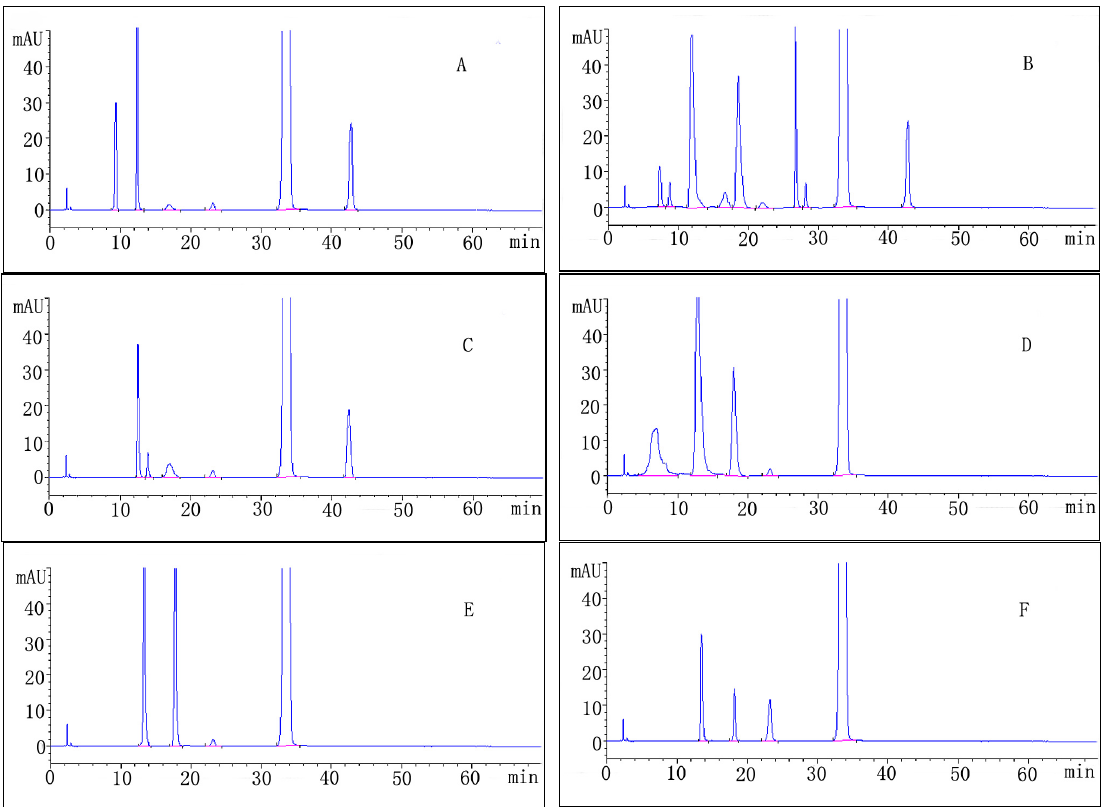
Figure 3. Chromatogram of micafungin sodium under stress conditions: ( A ) acid hydrolysis; ( B ) base hydrolysis; ( C ) aqueous hydrolysis; ( D ) oxidative degradation; ( E ) photolytic degradation and ( F ) thermal